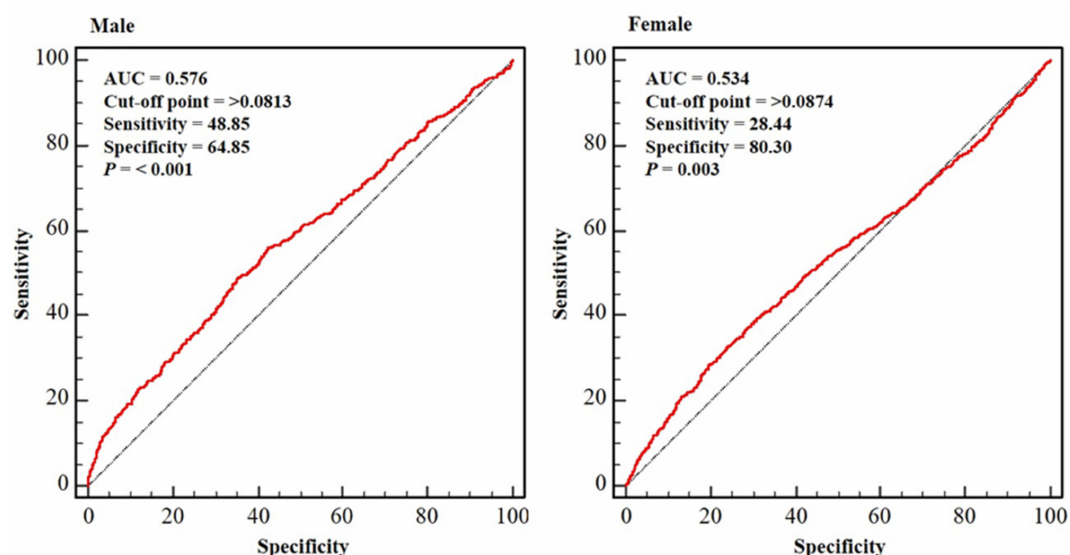
Figure 3. Sex-specific ROC curves indicating the ABSIs in the Osteoporosis group. Dotted blue line: reference; solid red line: area under the curve (AUC), indicating the accuracy of the A Body Shape Index (ABSI) for the identification of osteoporosis; cut-off value: the value of ABSI that predicts osteoporosis; sensitivity: the probability of individuals who actually have osteoporosis to be predicted to have osteoporosis; specificity: the probability of individuals who do not have osteoporosis to be predicted not to have osteoporosis. Abbreviation: AUC, area under